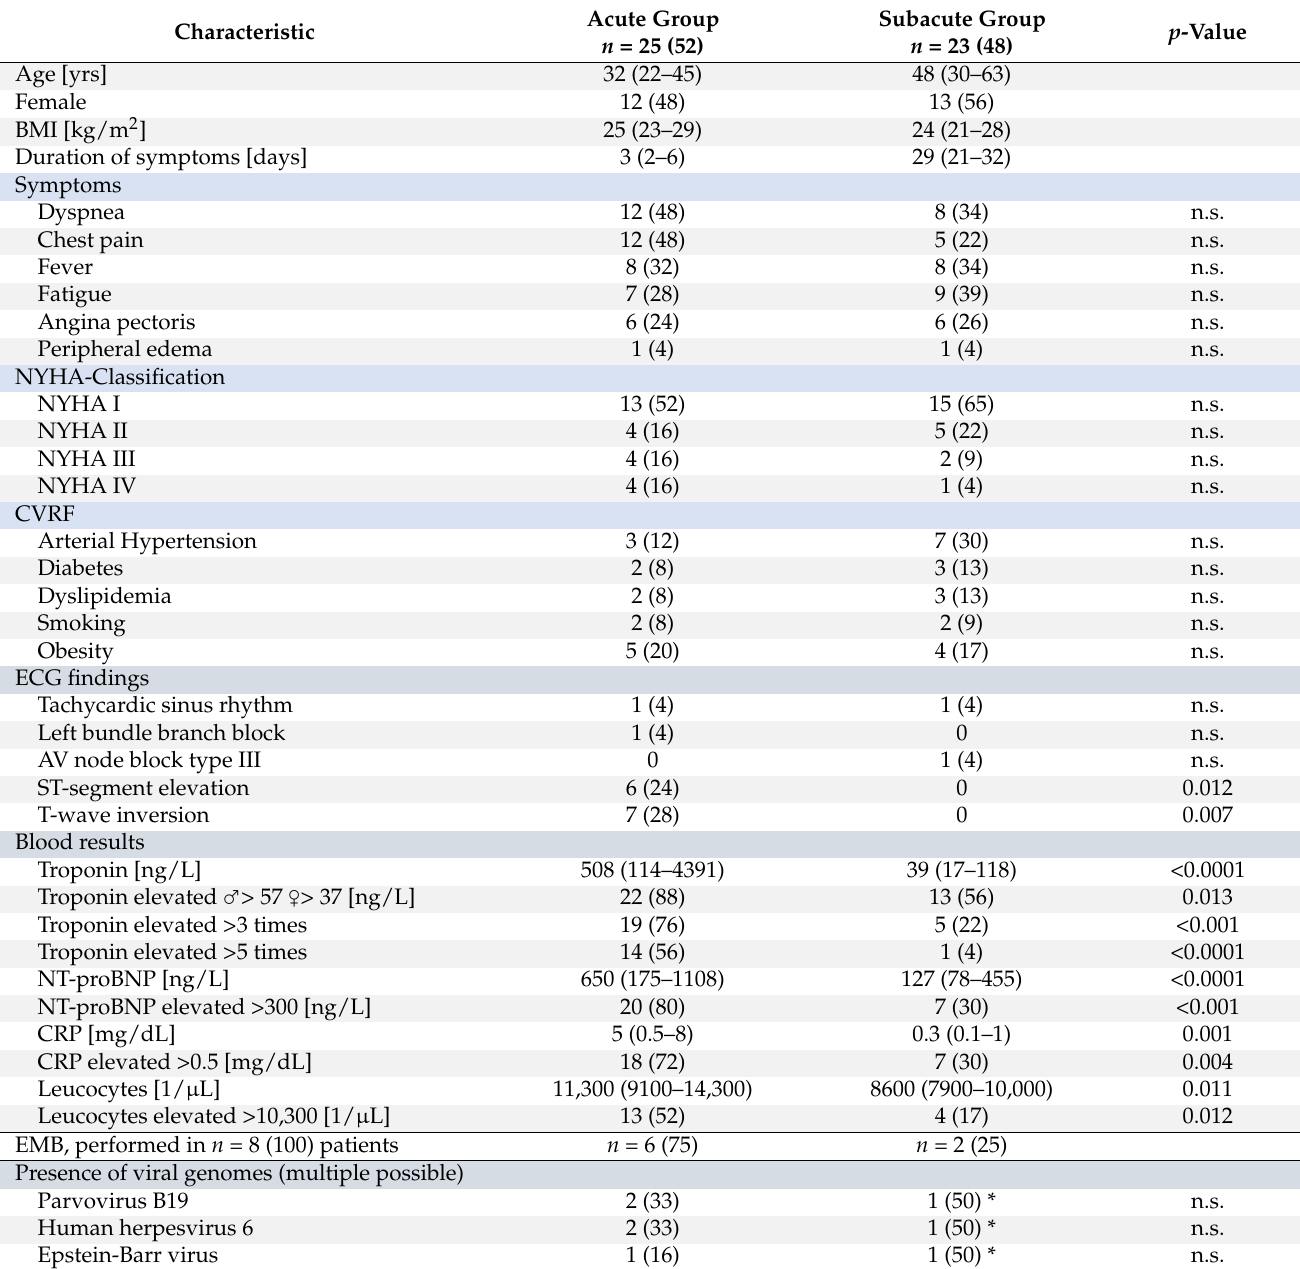
Table 1. Patient